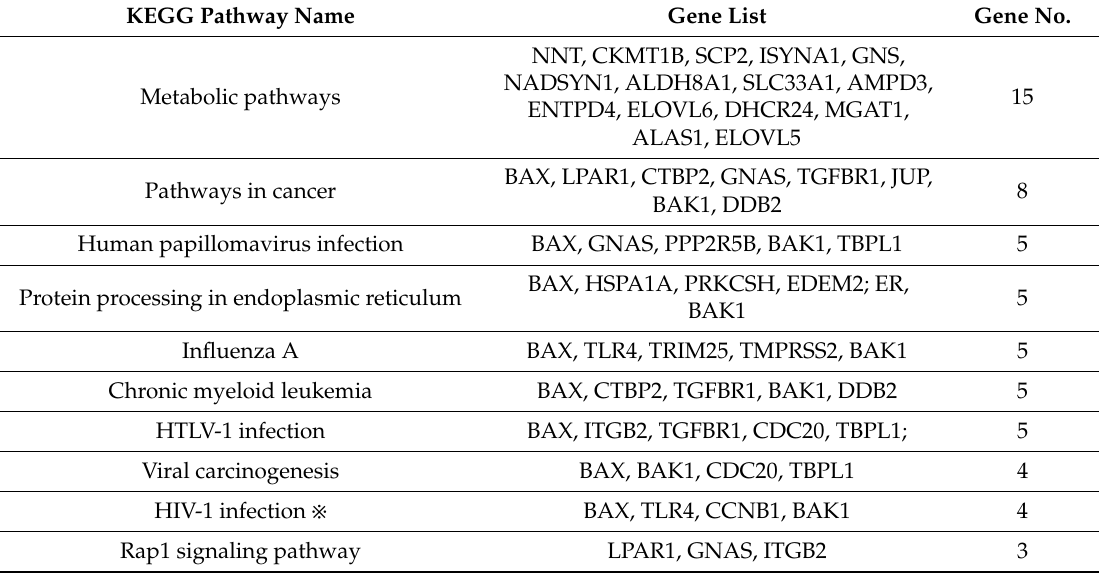
Figure 6. Functional annotation clustering (using DAVID v6.8) of DEGs enriched in milk EVs from BLV-infected cattle with HPL + HLDH in Experiment 2 (top 20 with high fold change). X-axis represented fold change and Y-axis represented clustering term. Table 3. KEGG pathways (important 10) of DEGs in milk EVs from BLV-infected cattle with HPL + HLDH in Experiment